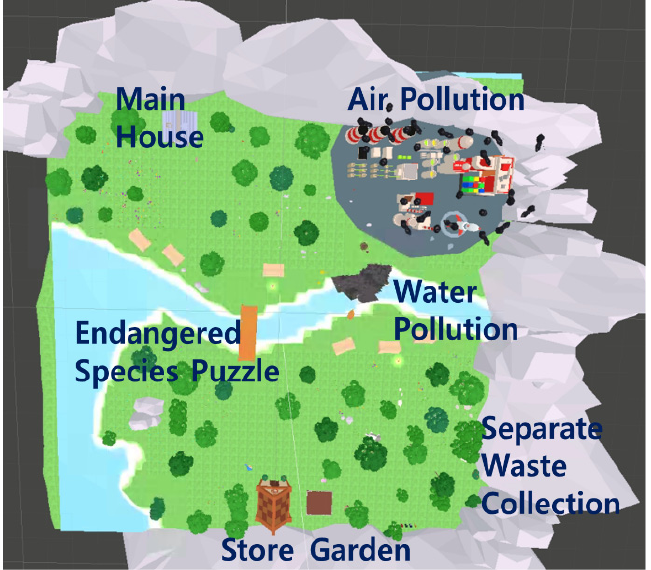
Figure 7. The village scene consists of a main house, a store, a garden, an air pollution area, a water pollution area, a separate waste collection area, and endangered species puzzles all around in the village.